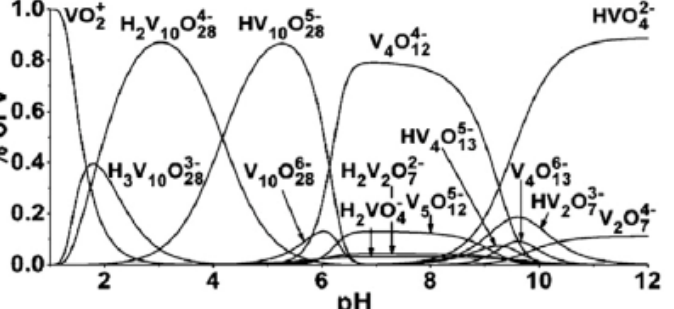
Figure 3. Distribution diagram in a solution of 50 mM NaVO 3 and 50 mM V atoms (5 mM V 10 ) in 0.15 M NaCl as a function of pH. The species are indicated by their formulas, including showing different protonation states. The figure is adapted with permission Ref. [90]. © 2012 by the American Chemical